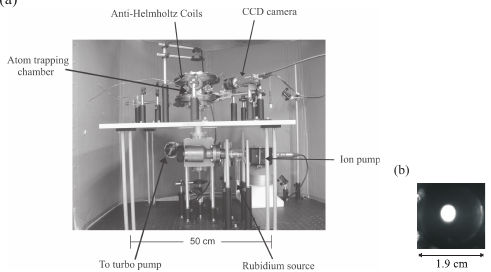
Figure 21. ( a ) A portion of the atom trapping setup. A pair of anti-Helmholtz coils is used to apply a magnetic field gradient. Two pairs of the trapping beams are aligned in the horizontal plane between the anti-Helmholtz coils. An orthogonal trapping beam is aligned along the vertical. ( b ) Image of trapped 85 Rb atoms recorded by a CCD camera. An optimized trap has a 1/ e 2 cloud radius of ∼ 1 mm and holds ∼ 10 7 atoms. The CCD image of the trap in ( b ) is saturated causing